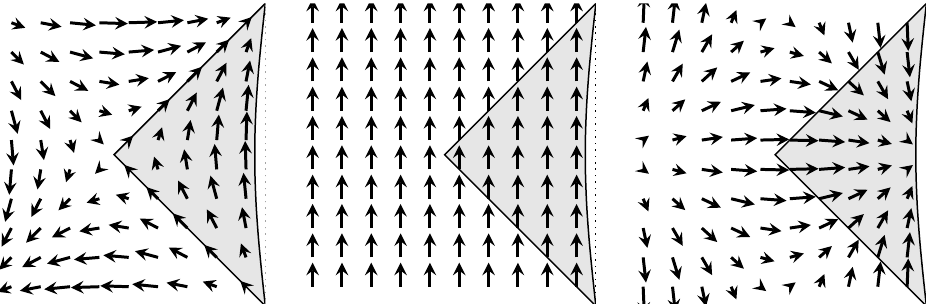
Figure 4. Vector (cid:13)ows of the Lorentzian generators B ( L ) , E ( L ) , and P ( L ) on a patch of global AdS 2 . For reference, we have drawn in a portion of the Rindler wedge with (cid:12)nite boundary location, as well as the right conformal